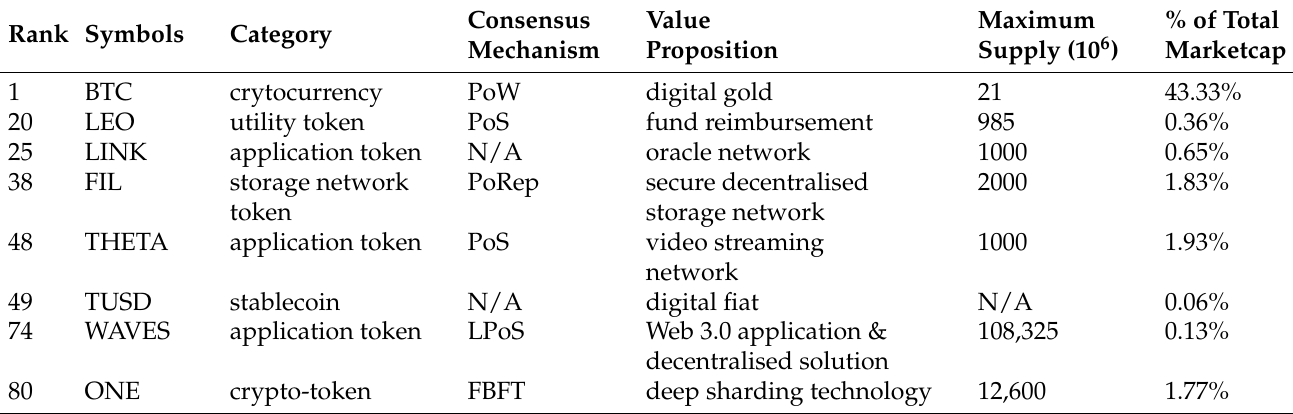
Table 3. Description of selected cryptoassets.